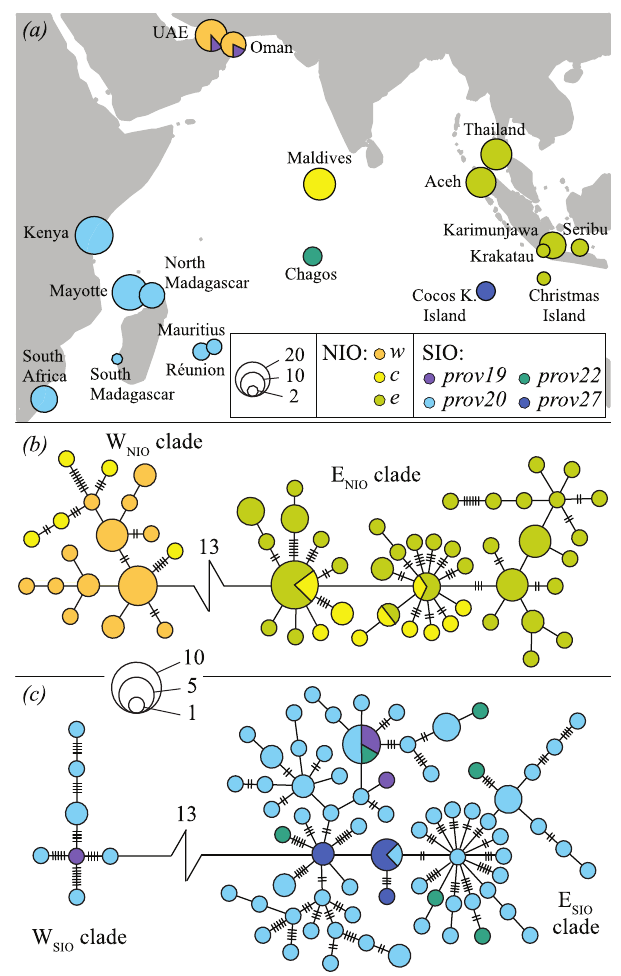
Figure 1. Phylogeography of the crown-of-thorns starfish in the Indian Ocean. (a) sampling locations from the Northern and Southern Indian Ocean sister-species (here denoted as NIO and SIO respectively), circles are proportional to sample size, colours indicate the regional grouping of populations that explained most of the variance amongst groups (NIO: w : west, c: central, e: east ; SIO: prov19 , 20 , 22 , 27 = Marine ecoregions regional provinces (Marine Ecoregions of the World: http://www.worldwildlife.org/science/ecoregions/marine/ provinces.htm; [19])). (b) and (c) Minimum spanning trees (CR) of NIO and SIO respectively, all haplotypes are separated by one mutational step unless denoted by a higher number of hatch marks, except the clades W NIO and E NIO as well a W SIO and E SIO which are separated by 13 mutational steps. Colours are the same as in (a) and circle size is proportional to frequency of occurrence.